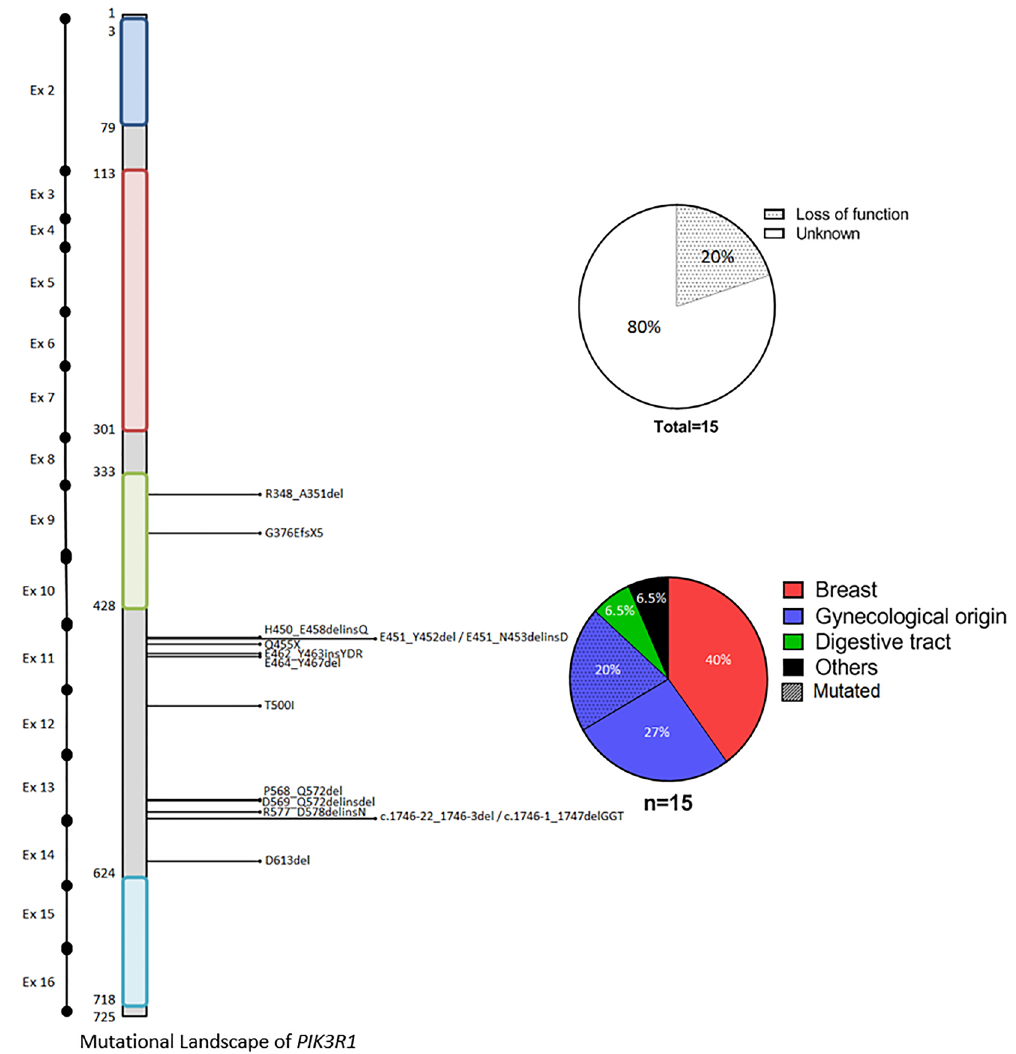
Figure 3. Mutational landscape of PIK3R1